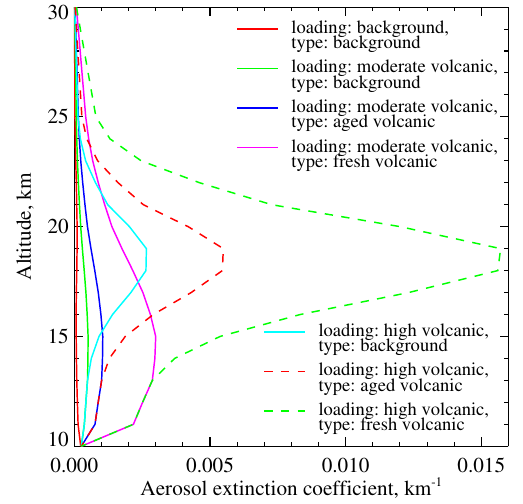
Fig. 12. Relative retrieval errors due to clouds for different observa- tion geometries (along SCIAMACHY orbit). The legend indicates the solar zenith angle (SZA) and relative azimuth angle (SAA) at a tangent point for each observation. Simulations are done for an ice cloud between 5 and 7km with an optical thicknesses of 10.